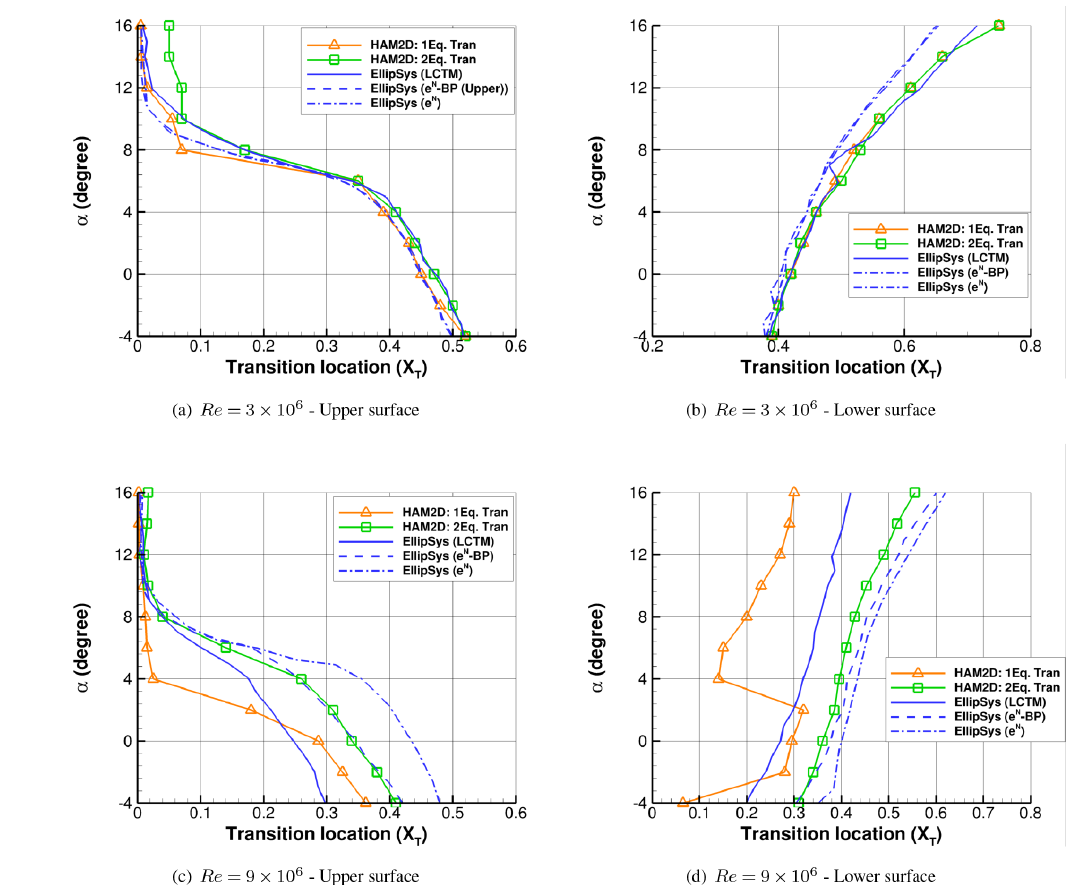
Figure 9. Comparison of variation of transition onset location with angle of attack for the DU-00-W212 airfoil predicted by HAM2D using one-equation and two-equation transition model with that by EllipSys2D using different transition models (Sorensen et al., 2014): γ − Re θ t (LCTM), e N model, and e N -BP model with bypass